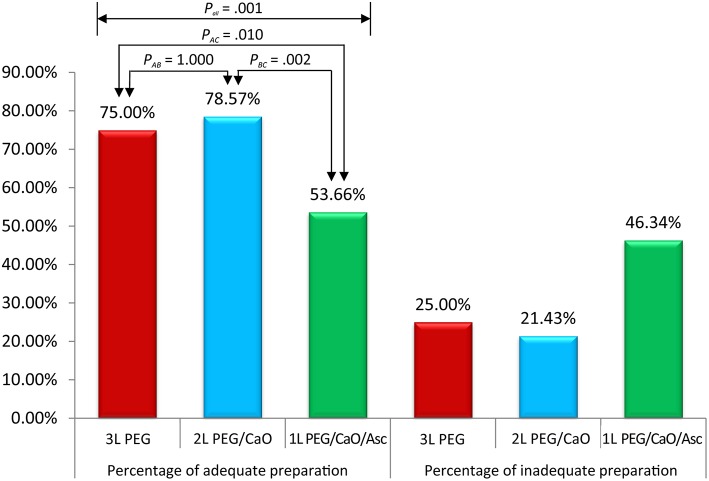
Percentages of adequate and inadequate bowel preparation among three groups. Pall corresponded to comparison of three groups, PAB corresponded to comparison between 3 L PEG and 2 L PEG/CaO groups, PAC corresponded to comparison between 3 L PEG and 1 L PEG/CaO/Asc groups, and PBC corresponded to comparison between 2 L PEG/CaO and 1 L PEG/CaO/Asc groups. All comparisons were tested by one-way ANOVA or Pearson χ2 analysis (Fisher's exact test if cell <5). A, B, and C represents 3 L PEG, 2 L PEG/CaO, and 1 L PEG/CaO/Asc, respectively. PEG, polyethylene glycol; CaO, castor oil; Asc, ascorbic acid.